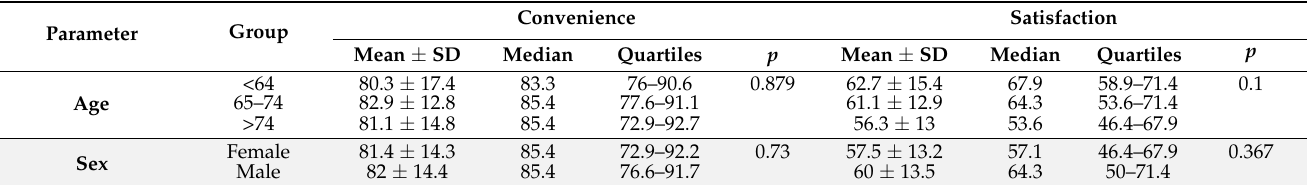
Table 2. Comparative analysis of sociodemographic and clinical variables for the PACT-Q2 conve- nience domain and for the PACT-Q2 satisfaction domain of the study group ( n =